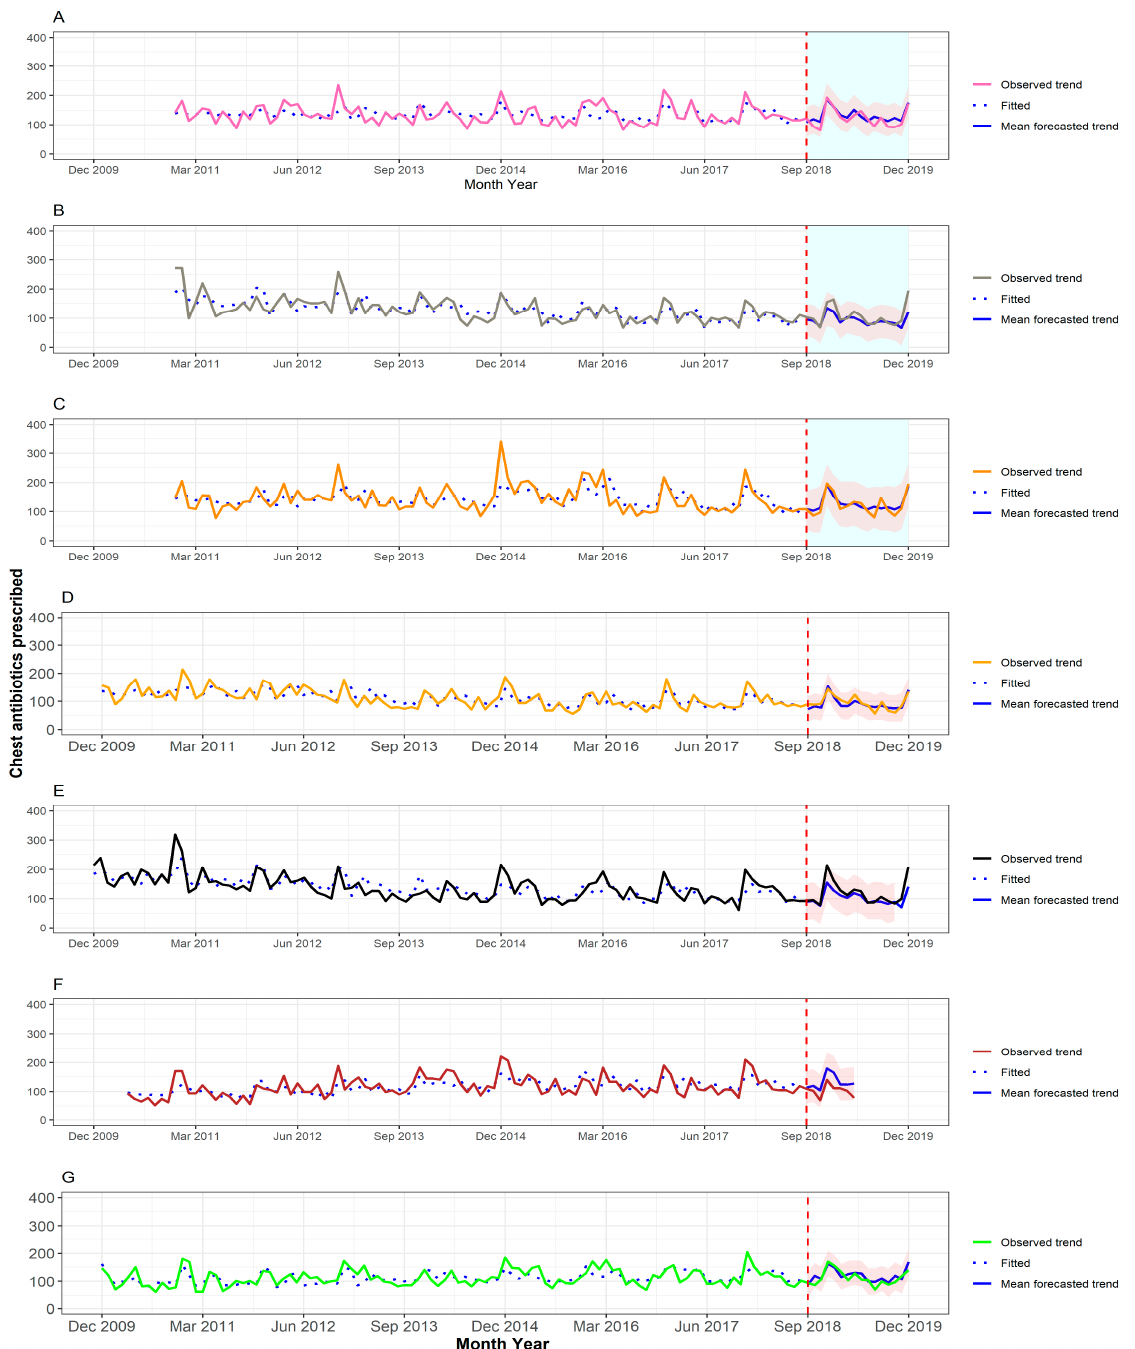
Figure 2. Time series for respiratory-tract-targeted antibiotics prescribed for adult patients across the different OOH primary care locations with CRP machines, ( A – C ), and those without CRP machines, ( D – G ). The fitted values obtained from the ARIMA models are depicted using a dotted blue line (pre-September 2018), and the forecasted mean trends are depicted using a solid blue line (post-September 2018), with the corresponding 95% confidence interval highlighted in red.